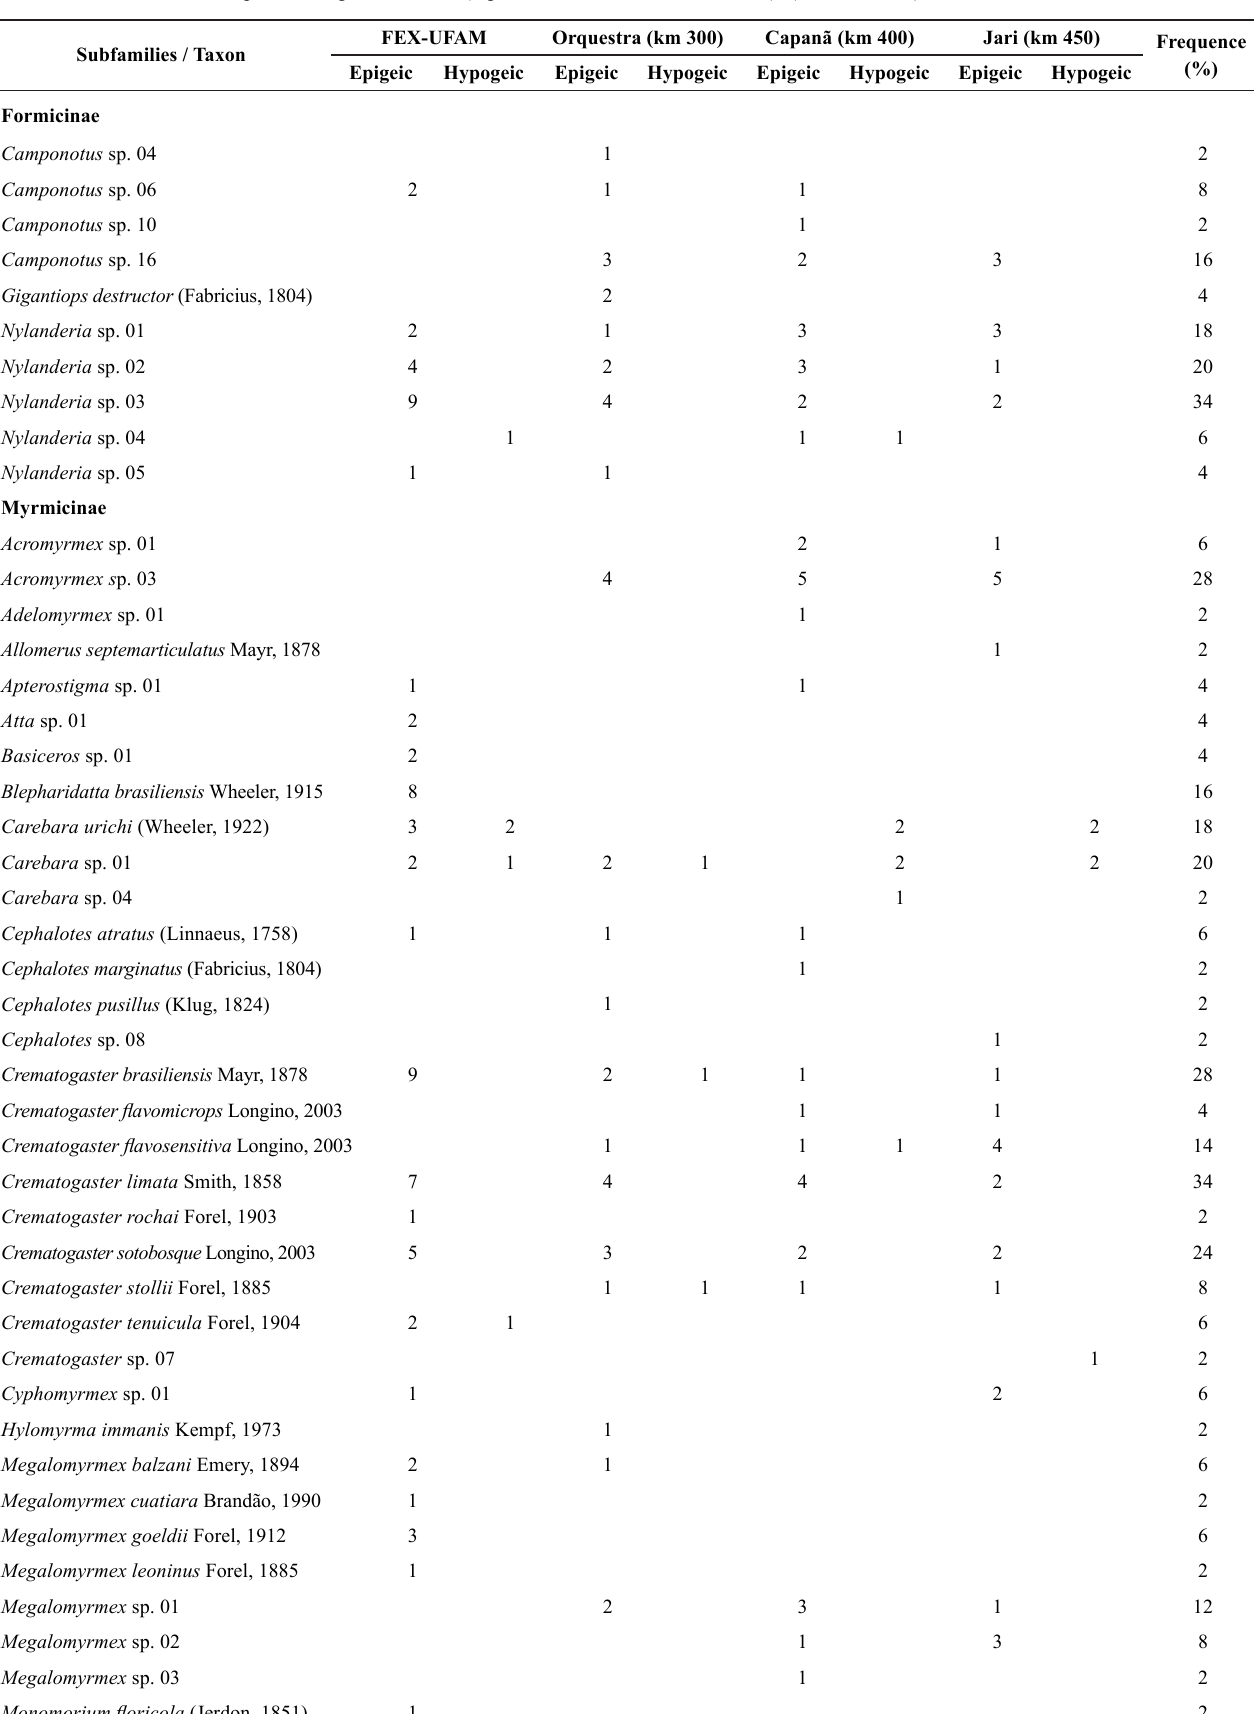
Table 2 . Occurrence and frequency of ant species and morphospecies sampled in the hypogeic (10 plots) and epigeic (7 plots) strata at UFAM and on BR 319 modules Orquestra, Capanã and Jari (5 plots in both strata for each site). (Continuation) Subfamilies / Taxon